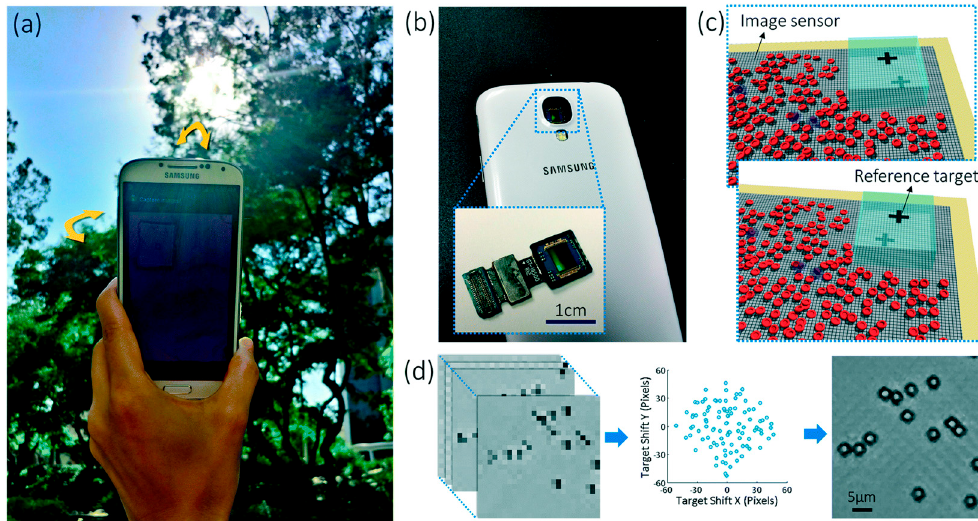
Figure 12. Lens-free microscopy example on a smartphone. The ambient light was used as the light source shown in panel ( a ) and the image sensor from the smartphone was used to capture images seen in panel ( b ). The samples were placed directly onto the imaging sensor of the smartphone shown in panel ( c ). Images of the cells are shown in panel ( d ). Reproduced from [118] with permission. © 2014 Royal Society of Chemistry.